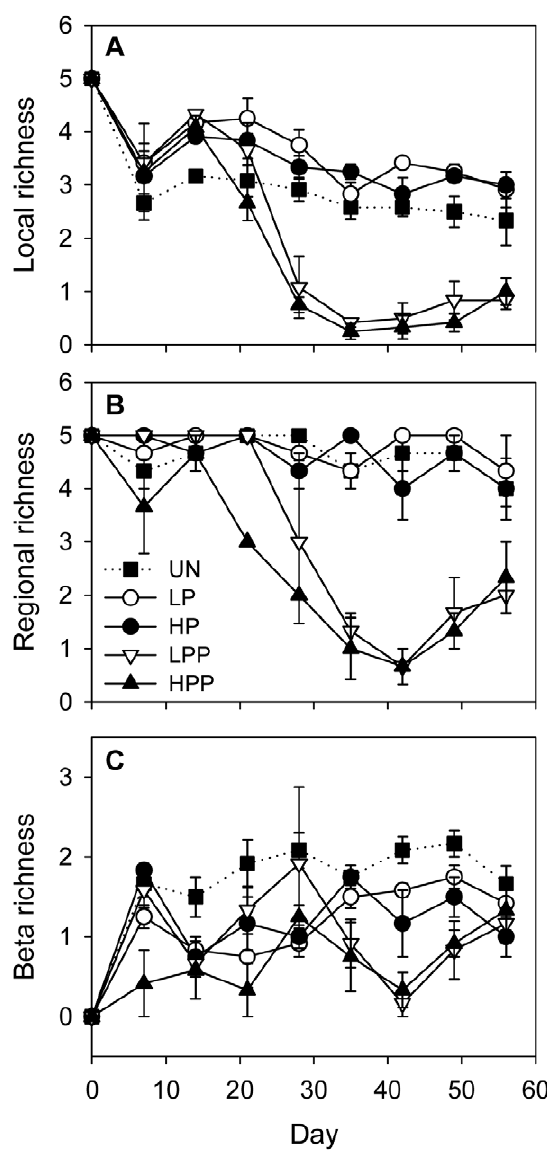
Figure 2. Local, regional, and beta richness of the prey community over the course of the experiment. The experiment compared an unconnected control (UN) and metacommunities with low prey dispersal (LP), high prey dispersal (HP), low predator and prey dispersal (LPP) and high predator and prey dispersal (HPP). Low connectivity is shown with open symbols, high connectivity with closed symboles. Circles mark the treatments with prey dispersal only, and triangles are the treatments with predator and prey dispersal. The unconnected control is shown with dotted line and filled squares. Values are means 6 SE